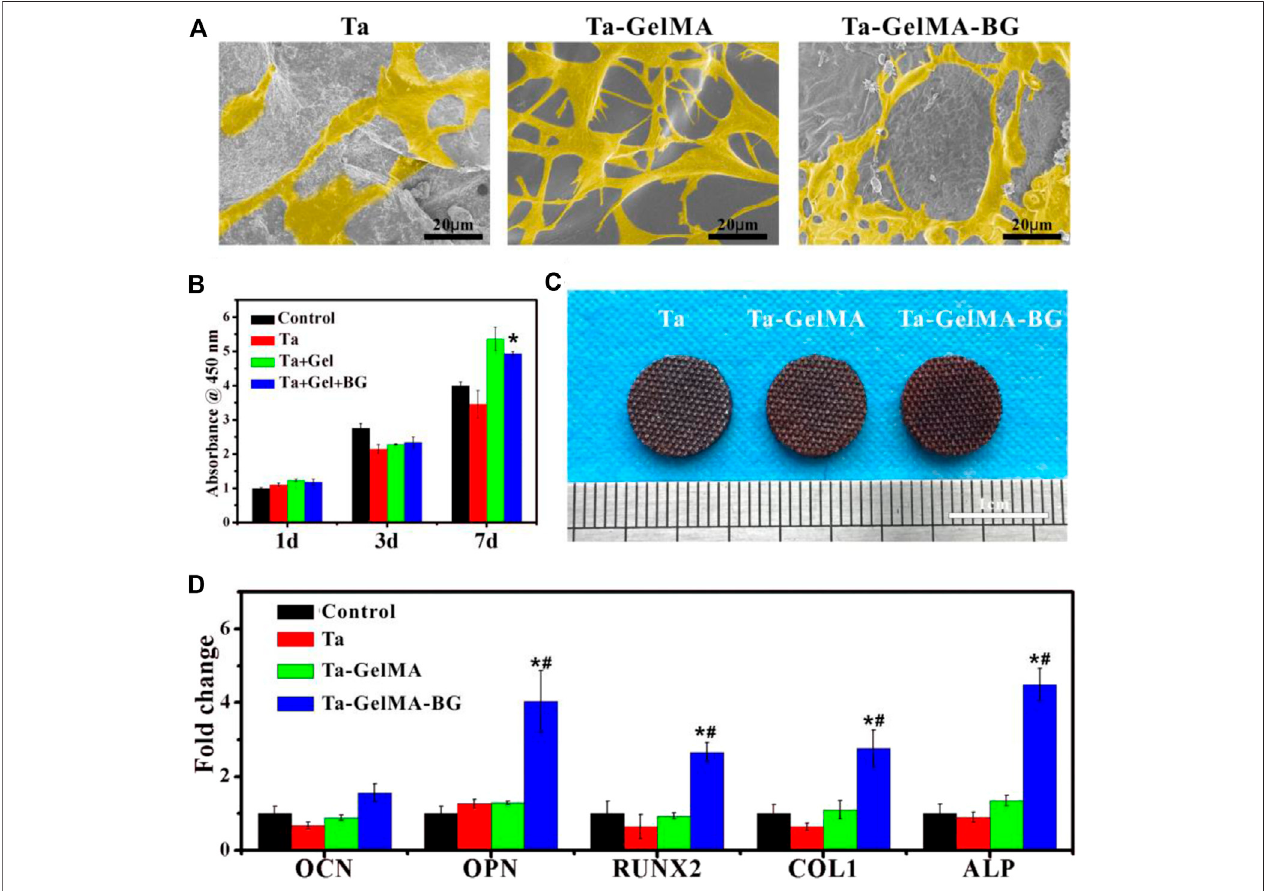
FIGURE 3 | In vitro biocompatibility and osteogenesis of Ta – GelMA – BG scaffolds: (A) SEM images of mBMSCs ’ attachment and spreading at day 2; (B) CCK-8 assayindicatingthecellproliferationatday1,3,and7; (C) AlizarinredofmBMSCs culturedwiththescaffoldsat14 days; (D) mRNAexpression ofosteogenesis-related genes (OCN, OPN, RUNX2, COL1, and ALP) incubated with various groups for 7 days. (*) p < 0.05 vs Ta group; ( # ) p < 0.05 vs Ta – GelMA group.